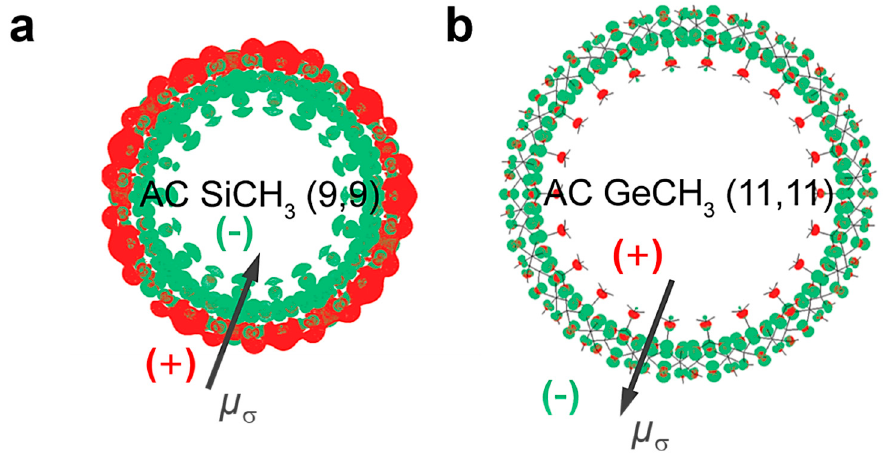
Figure 15. Front view of the real-space separation between the valence band (green) and the conduction band (red) edges for armchair methylated INTs (OH) 3 Al 2 O 3 Y (CH 3 ). ( a ) Y = Si; ( b ) Y = Ge. The black arrow illustrates the direction of the permanent dipole surface density µ σ of the nanotube wall. Adapted with permission from [73].